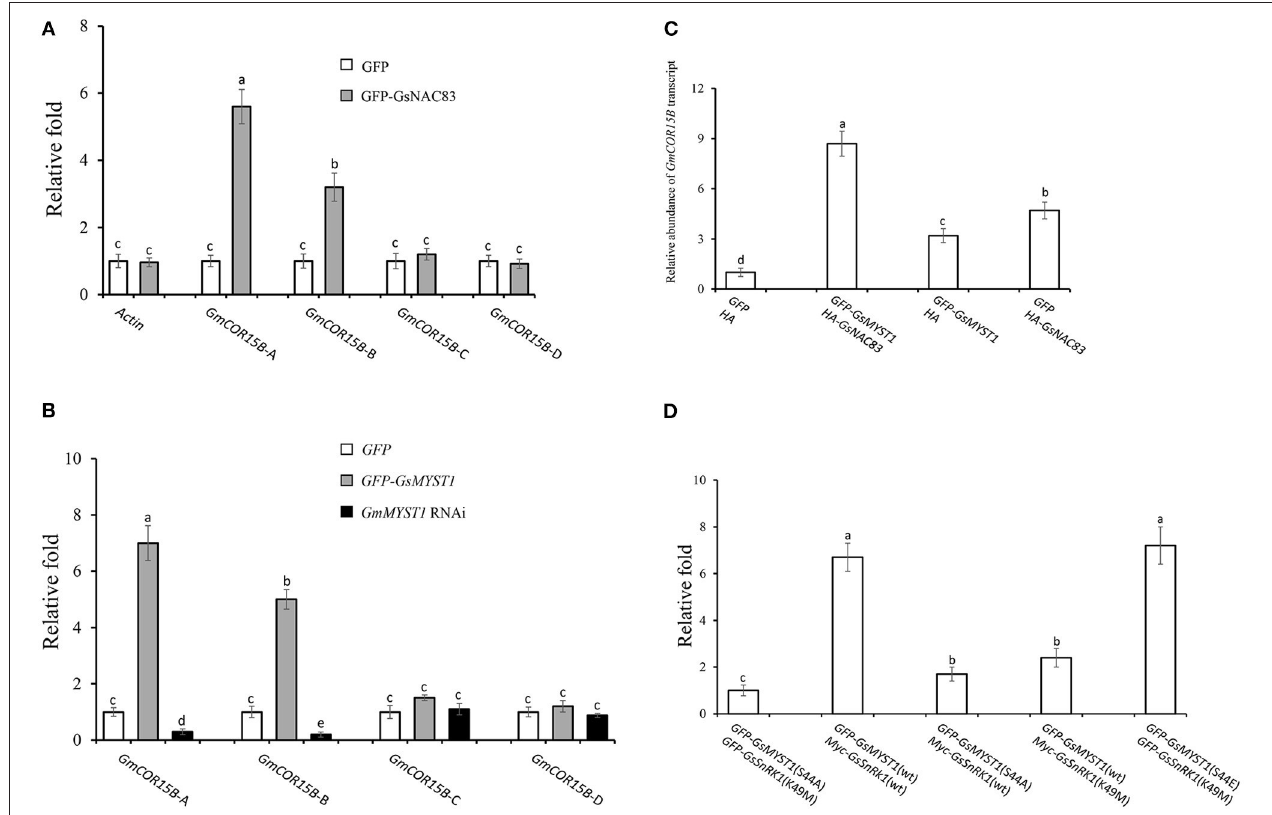
FIGURE 6 | Regulation of COR15B gene expression by GsSnRK1-GsMYST1-GsNAC83G module. (A) Analyses of binding sites of GsNAC83 on COR15B promoter using ChIP-PCR approach. (B) Analyses of acetylation of COR15B gene by GsMYST1 using ChIP-PCR approach. (C) Effect of GsNAC83 and GsMYST1 on the expression of COR15B revealed using qRT-PCR. (D) Effect of GsMYST1 phosphorylation by GsSnRK1 on acetylation of COR15B gene. Bars indicate SE, the t-test, and the columns were shown from three biological triplicates ( t -test, p < 0.05, expressed in different small letter alphabets).